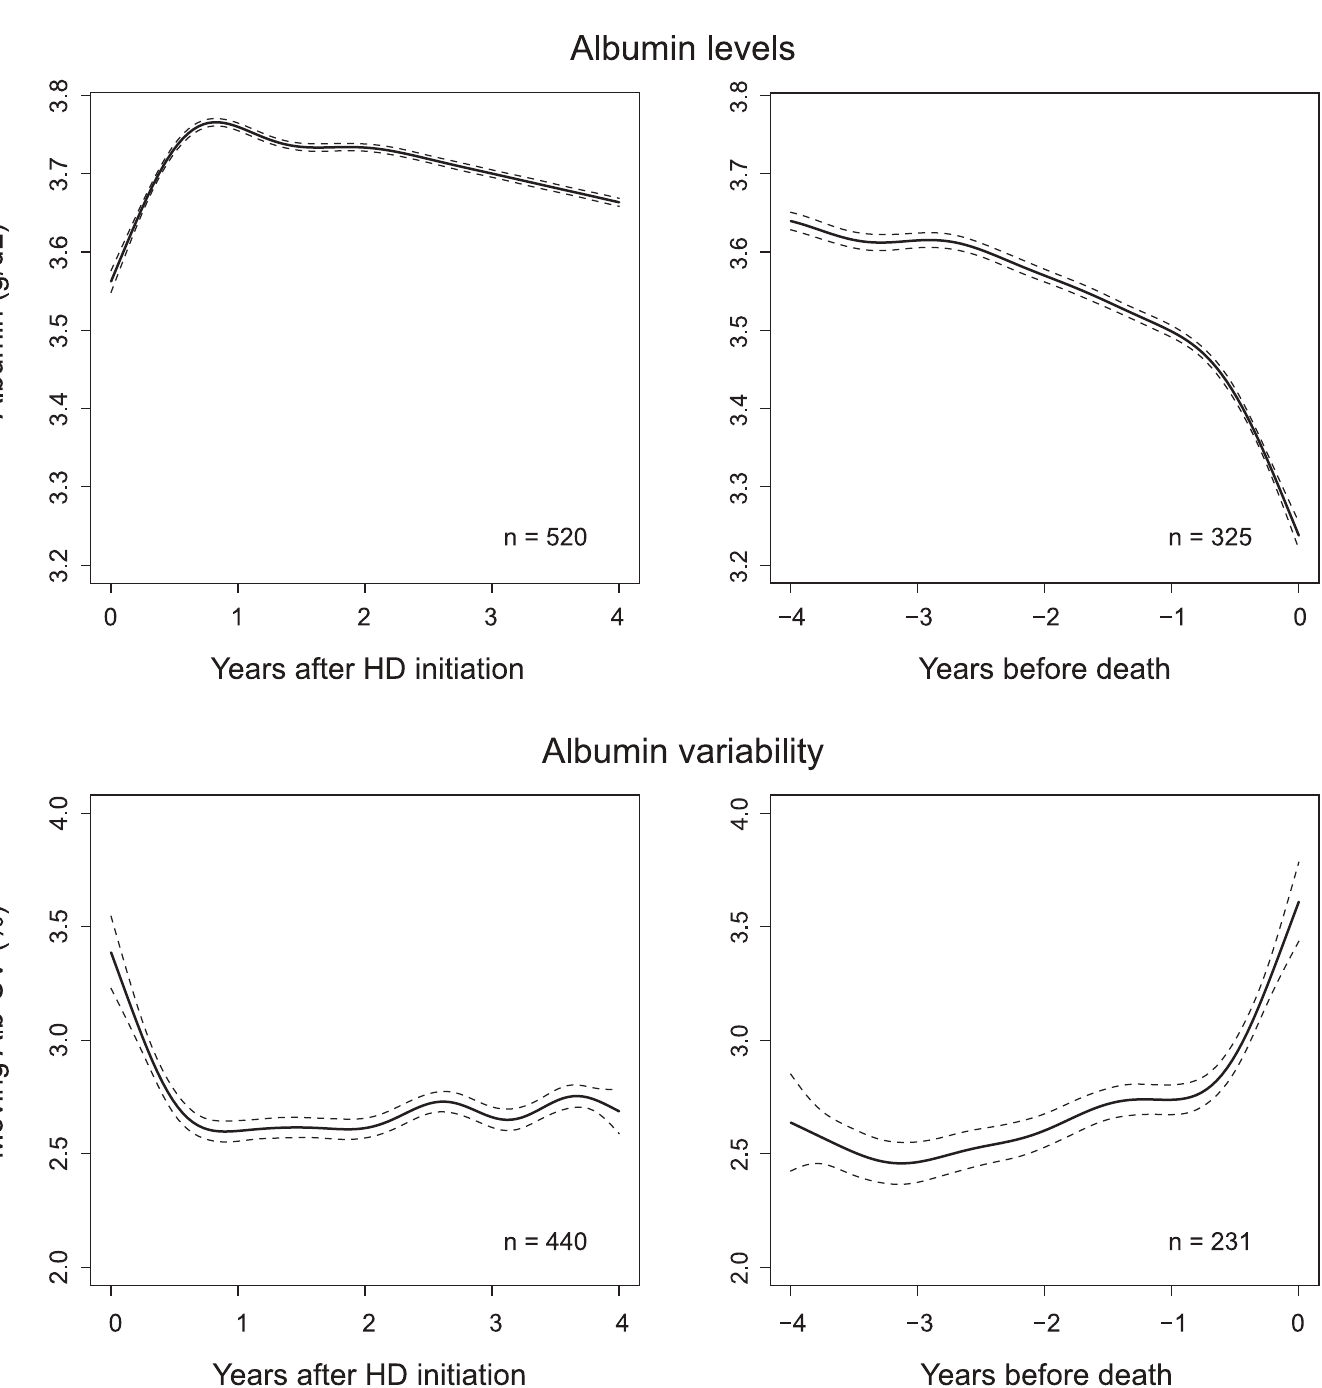
Fig 9. HD initiation and death-associated albumin dynamics estimated using generalized additive mixed models. Upper panels:All the albumin measurements for the post-HD initiationsubcohort or the before death subcohort were fitted using a generalizedmixed model with the time interval as a fixed variable and the subject ID as a random variable. The dotted lines represent the 95% confidenceintervalof the fixed term. Lower panels: The moving CV values were calculatedusing all the albuminmeasurements that had been recordedin January2007 or thereafter; these values were fitted using a generalized mixed model in a similar manner. Note that the moving CV values were not log-transformed. The numberof analyzedsubjects is labeledin each panel.